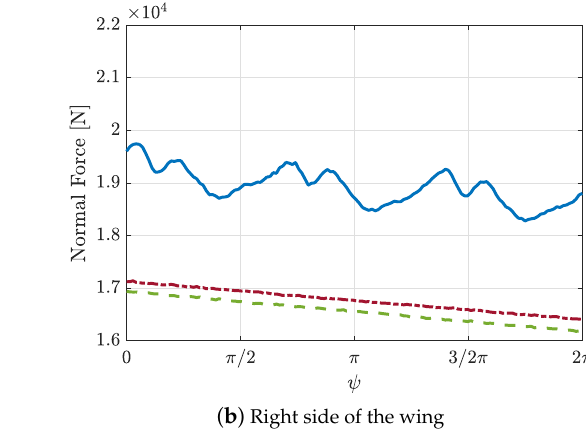
Figure 19. Azimuthal history of wing normal force during a rotor revolution at bank angle φ = 30°, ( a ) left side and ( b ) right